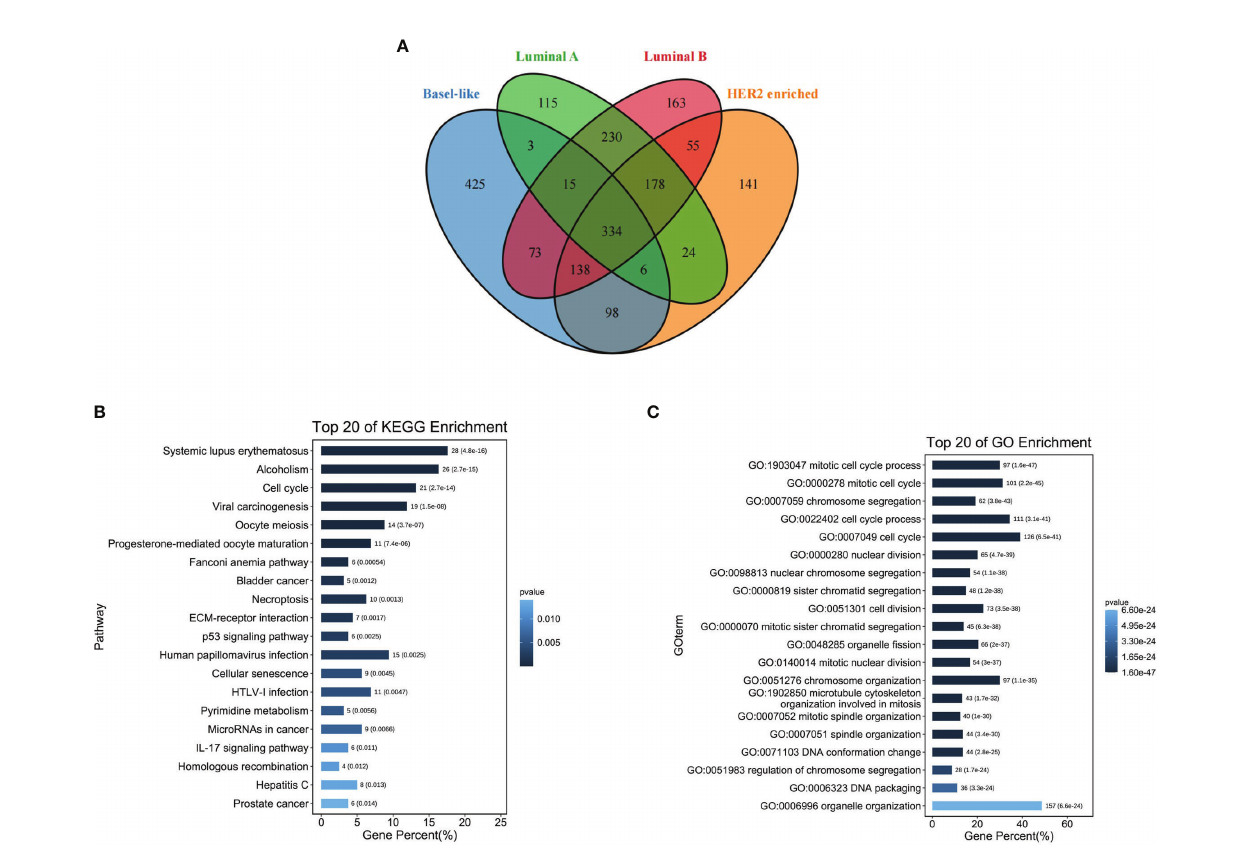
FIGURE 3 | Functional enrichment analysis of differentially expressed genes in four types of breast cancer. (A) Venn diagram showing four types of breast cancer differentially up-regulated overlapping genes; (B) Overlapping gene KEGG pathway enrichment analysis; (C) Overlapping gene GO function enrichment